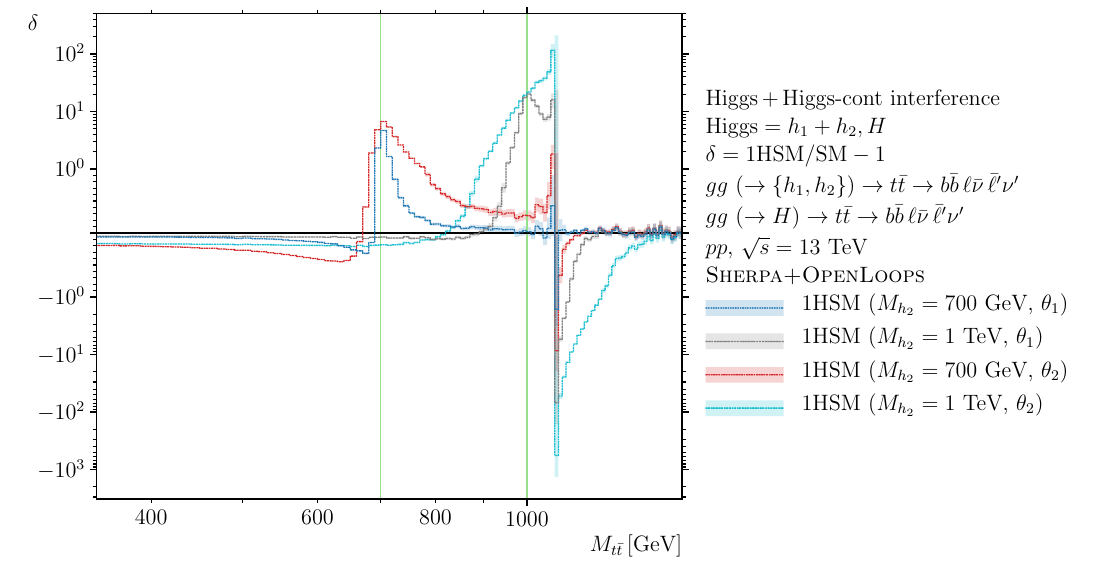
Figure 18 . M its interference with the background in the 1HSM ( M h the SM for gg ( σ ( h 1+2 +I(C)) to σ ( H +I(C)). Other details as in figure 4.